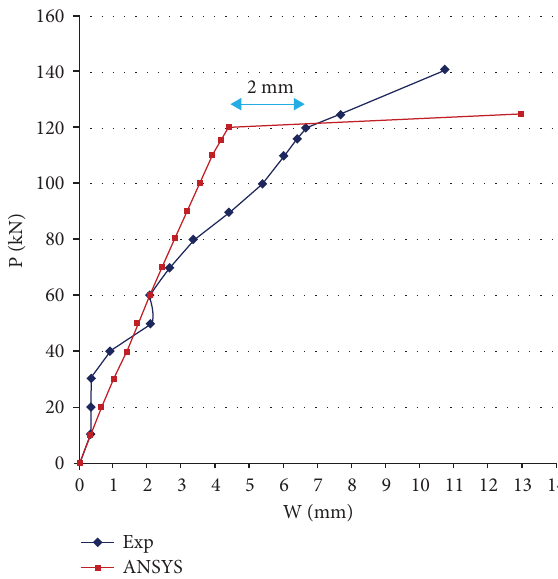
Figure 8: A vertical displacement could be seen in the middle of the span where the beam was